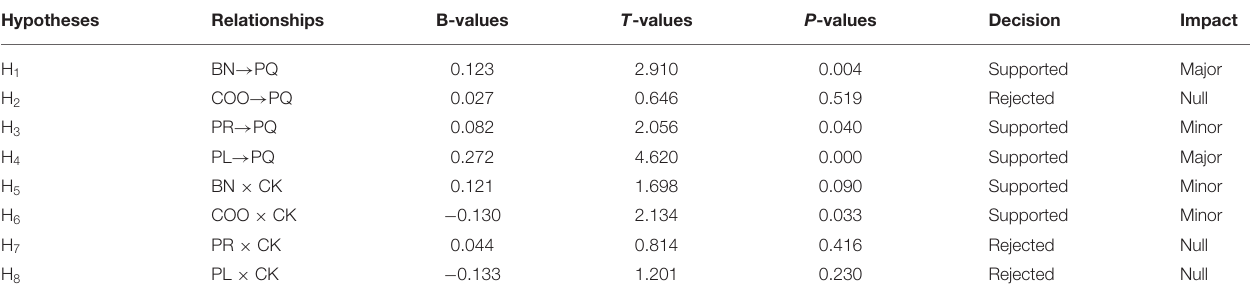
TABLE 12 | Path coefficients of